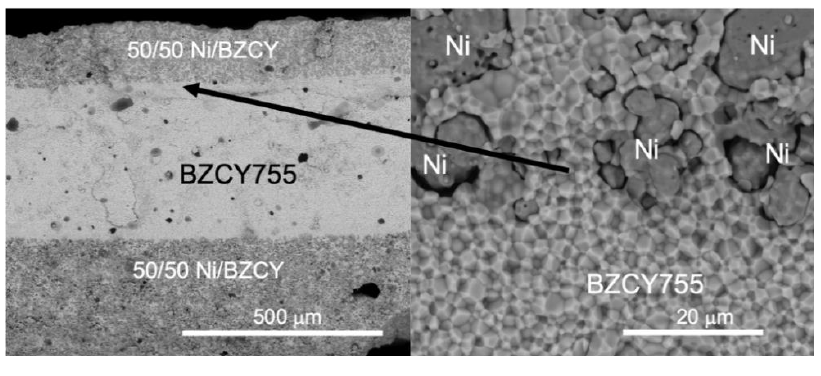
Figure 5. Back-scattered electron micrographs of sintered and reduced BZCY755/Ni//BZCY755//BZCY755/Ni fractured cross section.